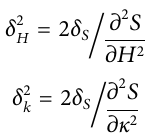
Frontiers in Earth Science |